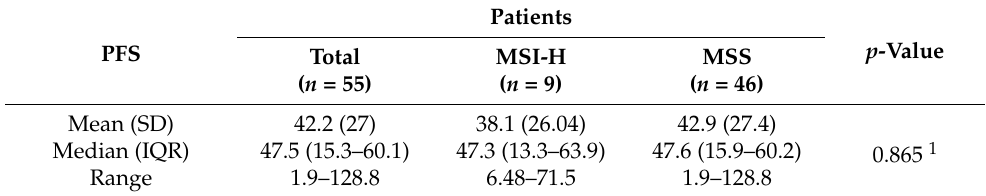
Figure 1. Patients’ distribution for histologic grade by MSI.